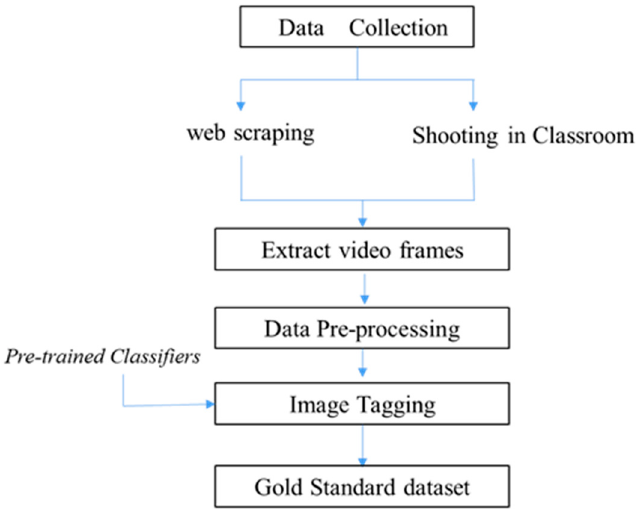
Figure 4. The process of dataset production (visually showing the collection and data processing process of the Classroom-Face dataset).